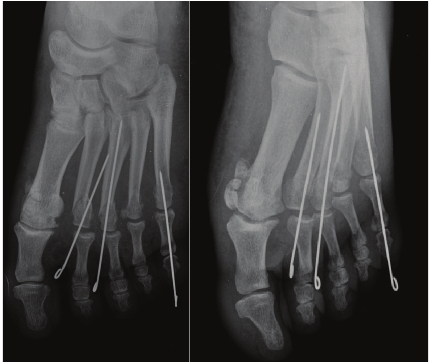
Figure 3: Stabilized dislocated fifth MTP and displaced second and third metatarsal head with transarticular